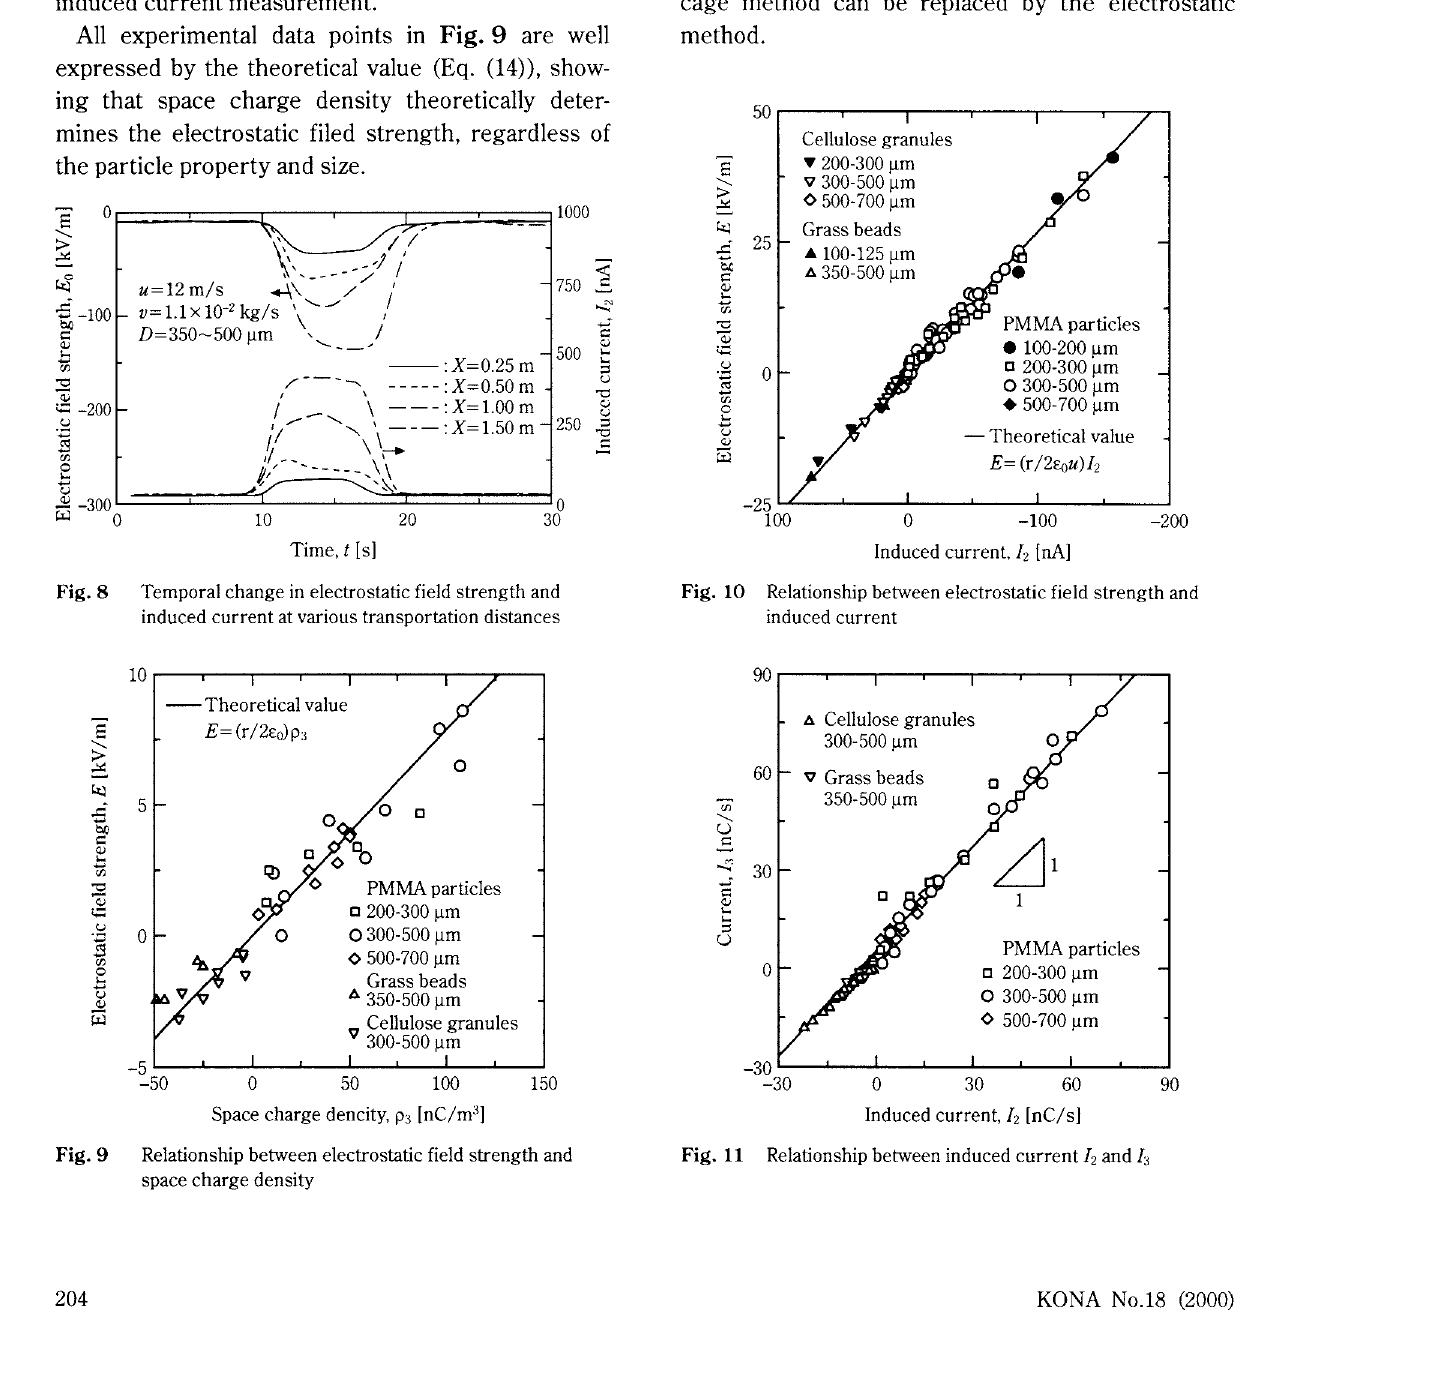
Fig. 11 Relationship between induced current [z and /